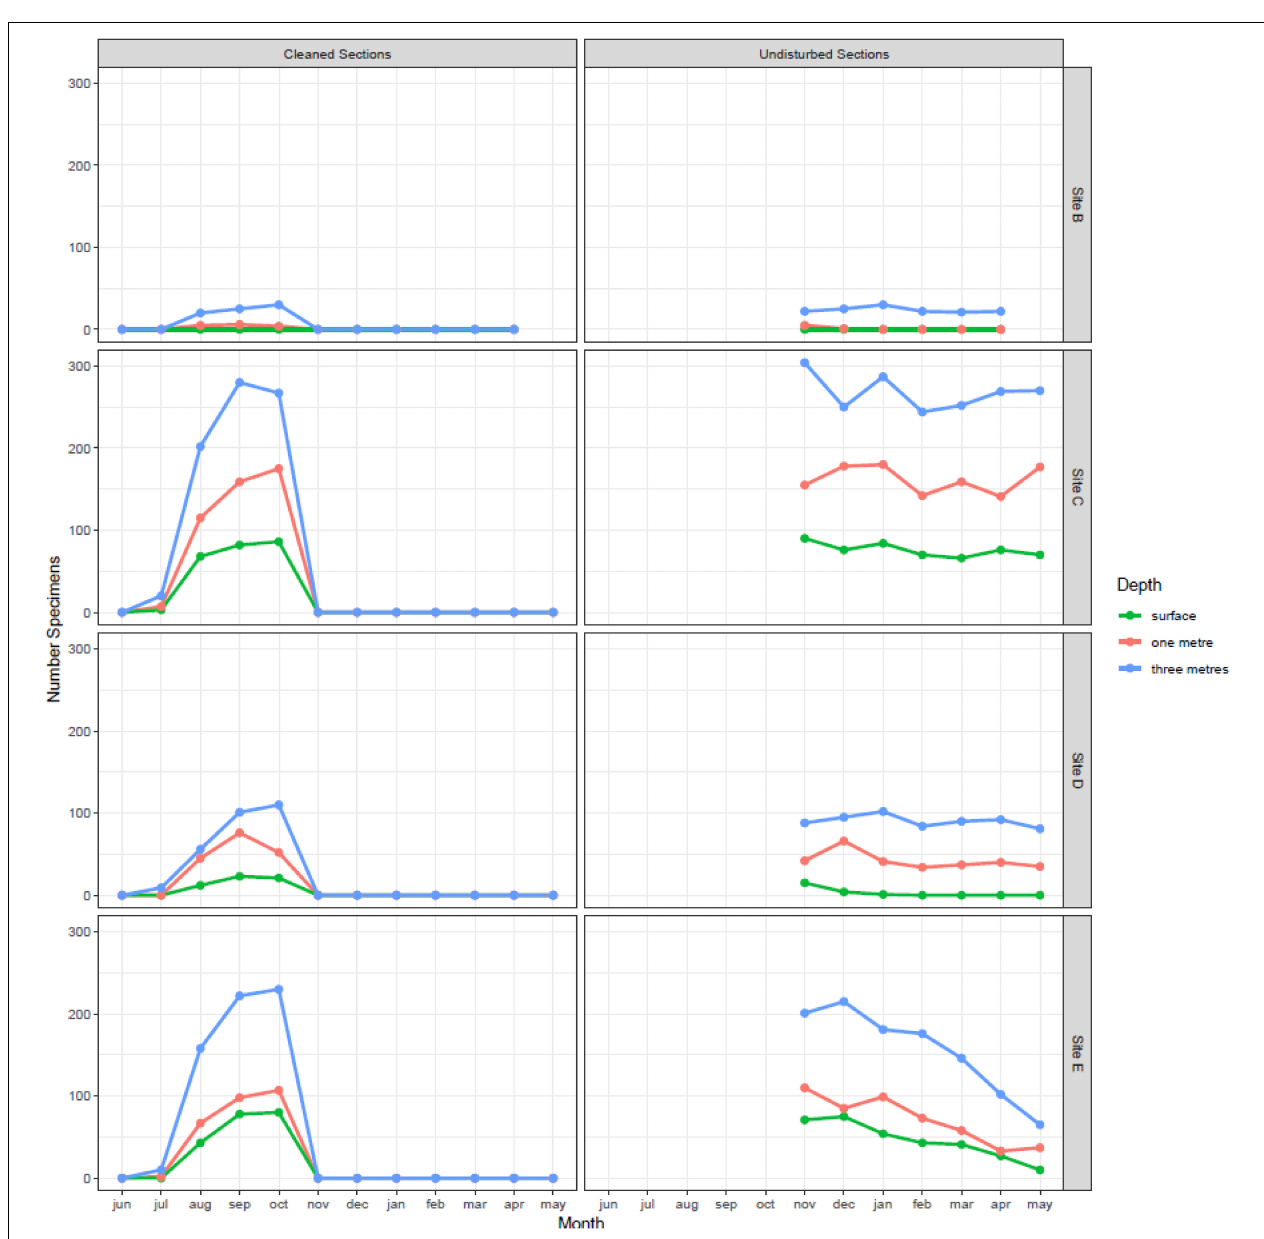
FIGURE 4 | Monthly variation in the number of zebra mussel found at different depths and at different locations in Cardiff Bay. Left panel shows results for panels scrapped clean every month during the growing season and right panel the results for panels left undisturbed and sampled after the end of the growing season.